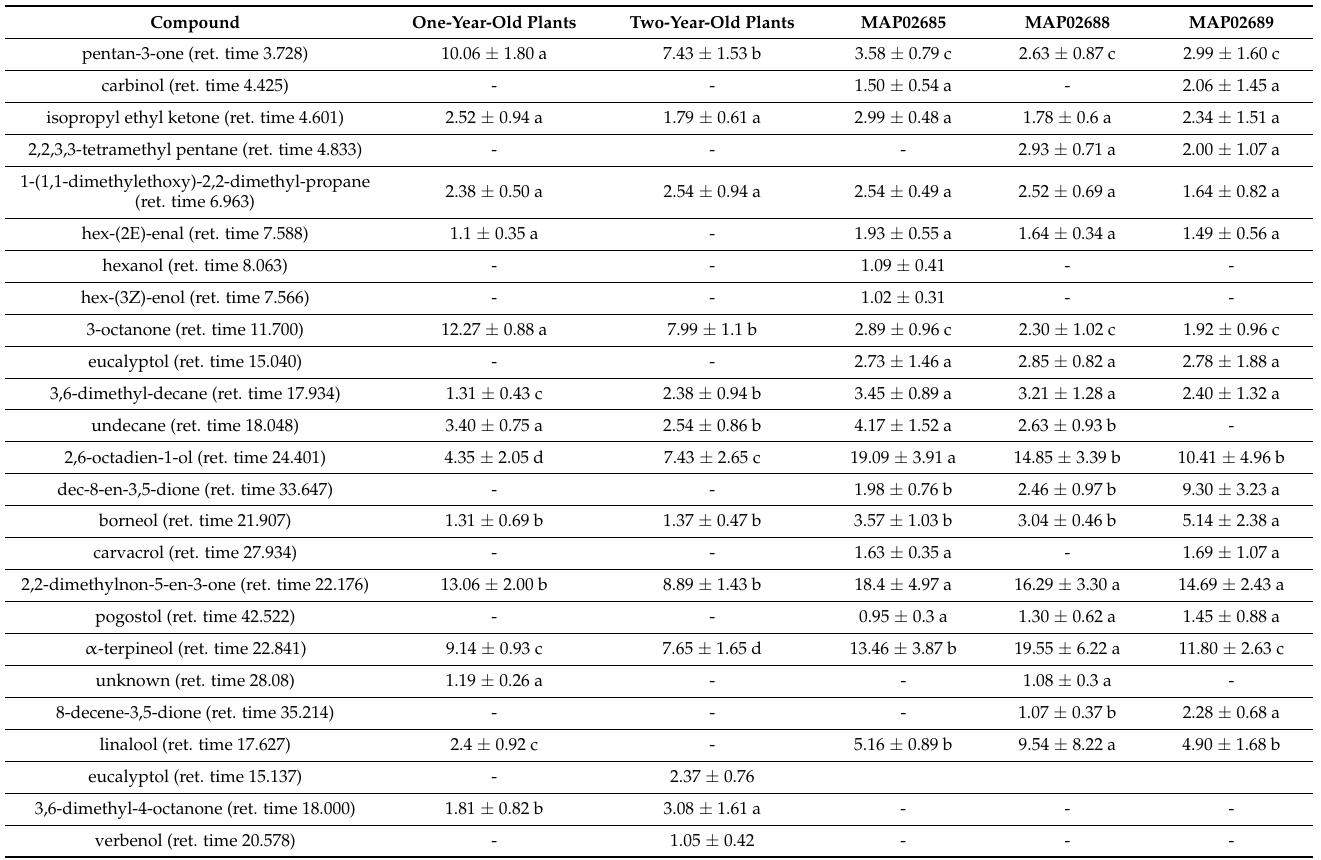
Table 2. Average relative peak area ± standard deviation (SD) (%) of individual compounds in hydrosol (average ± SD) in two- and one-year-old immortelle plants ( H. italicum ) and in three Croatian populations (MAP02685, MAP02688, MAP02689) of immortelle plants ( H. italicum ). Different letters indicate statistical differences between